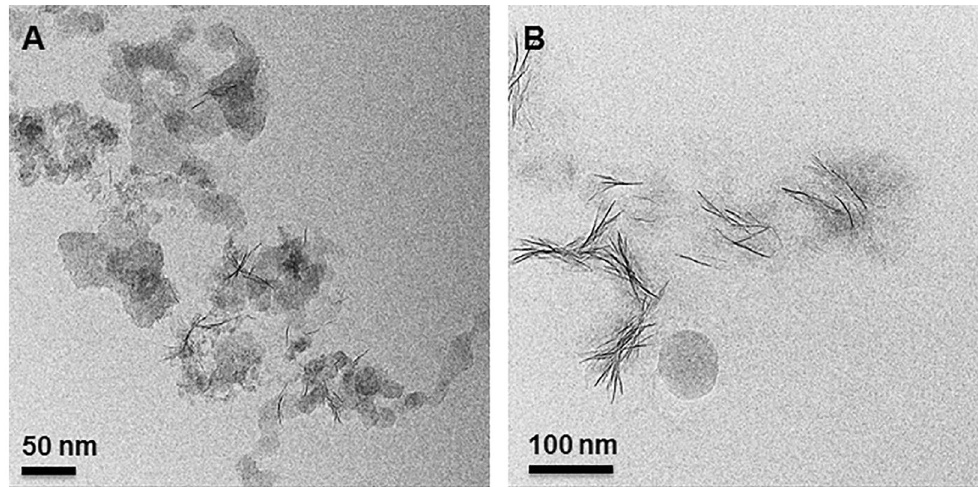
Figure 6. ( A ) Cryo-TEM image of sauconite synthesized with 1.0 M succinate at pH 0 9.0 after 6 h at 90 °C. The presence of irregular-shaped, possibly gel-like particles seen in Fig. 3A,B in their dispersed state. The